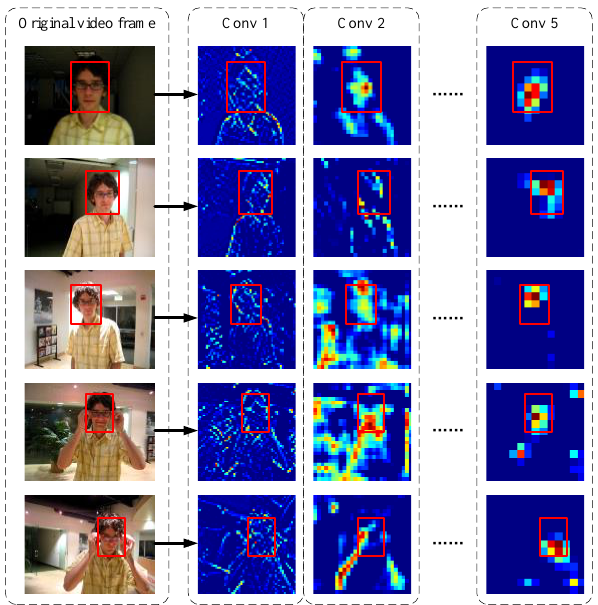
Figure 1. The response of different convolutional layers to the object in the input